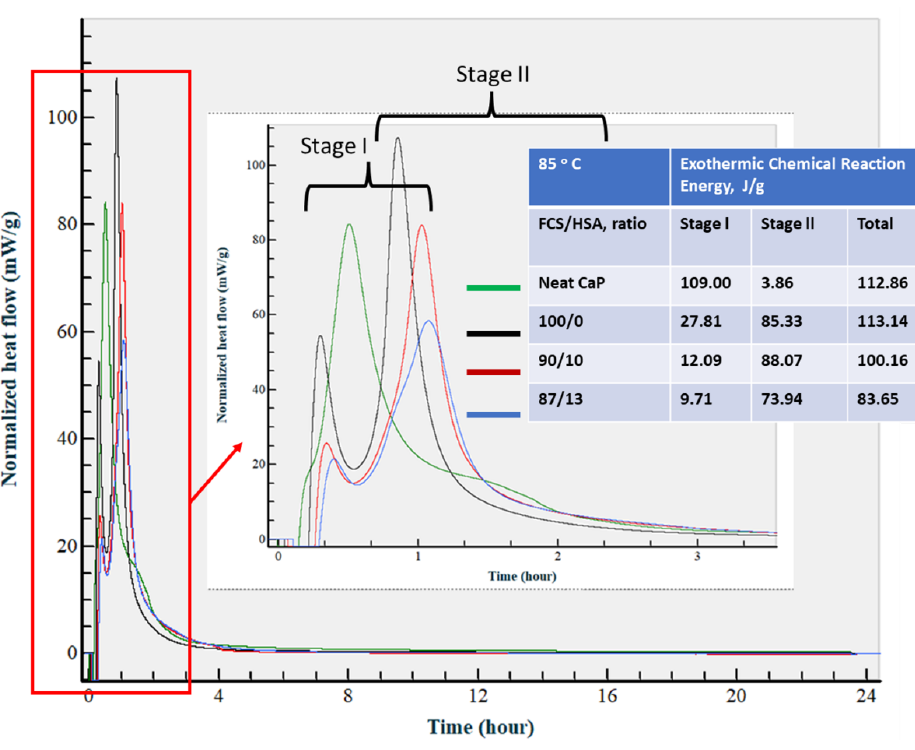
Figure 27. Calorimetric curves and normalized heat values for neat CaP cement and CaP composites made with FCS/HSA ratios of 100/0, 90/0, and 87/13 at temperature of 85 °C.